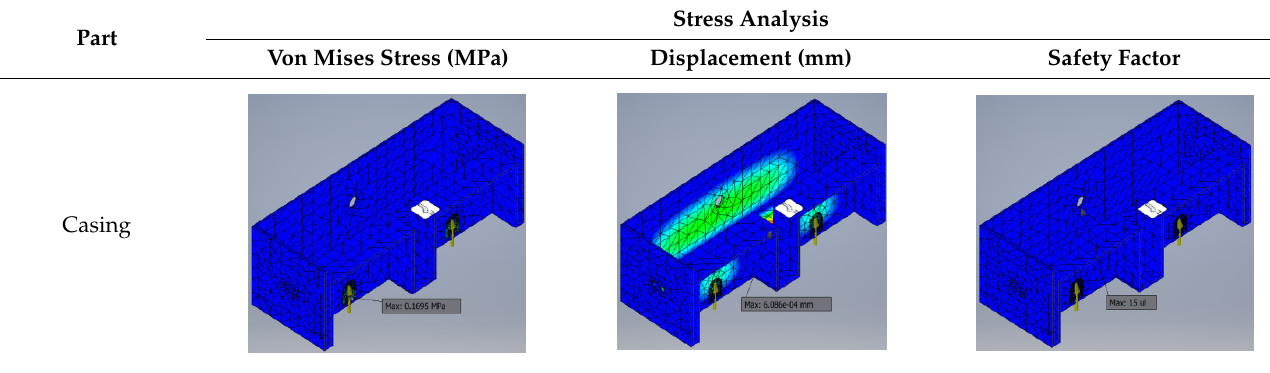
Table 20. Stress simulation results for the prototype (pictures).